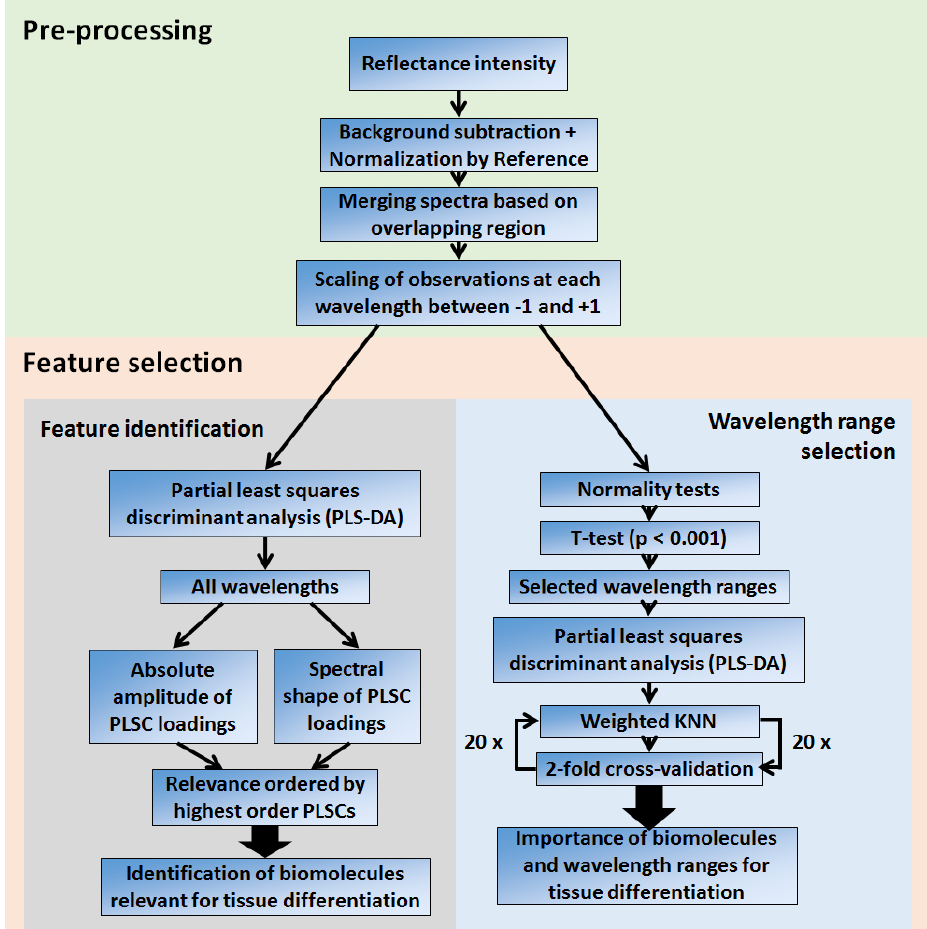
Figure 2. Flowchart of the steps of our spectral analysis.